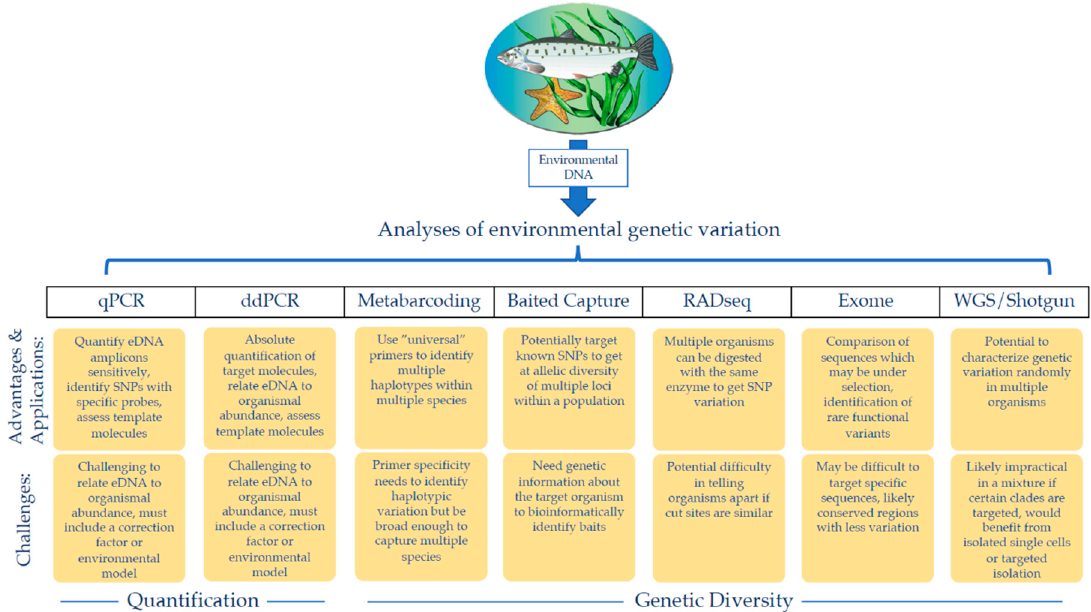
Figure 1. Possible avenues of analyzing environmental DNA (eDNA) for population information. After eDNA is shed into the water column by target organisms of interest, collected, and extracted, multiple analyses can be used to obtain population data. These analyses have diverse applications, highlighted in the top yellow row, but each technique also presents its own challenges, highlighted in the bottom yellow row.